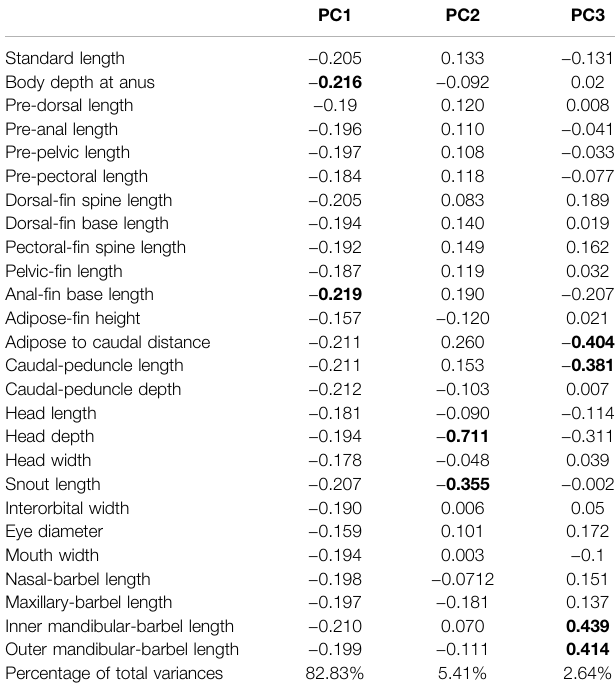
TABLE 6 | Variable loadings in the fi rst to third axes of the principal component analysis among eight allopatric populations within T. albomarginatus